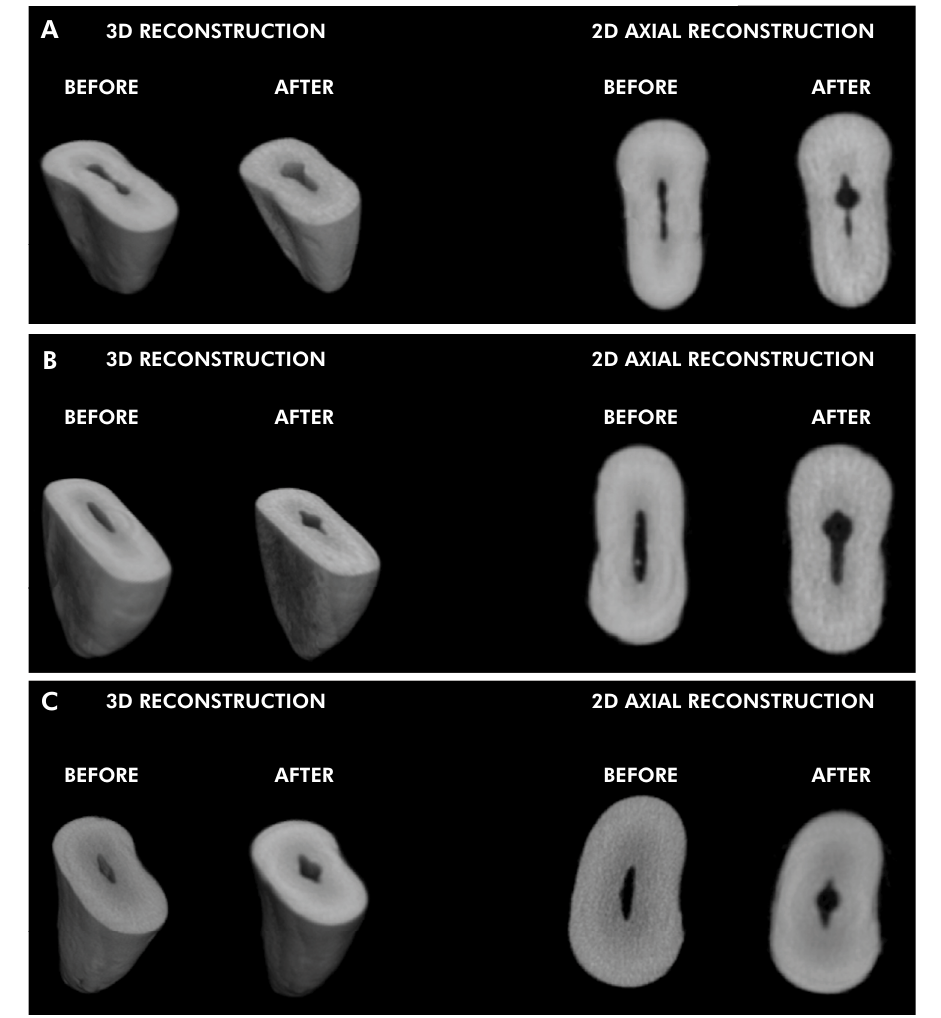
Figure 1. 3D reconstructions of representative root of mandibular incisors before and after instrumentation; and 2D image of axial reconstruction at 3 mm from the cementoenamel junction before and after biomechanical preparation: (A) XP; (B) XP-K; (C)